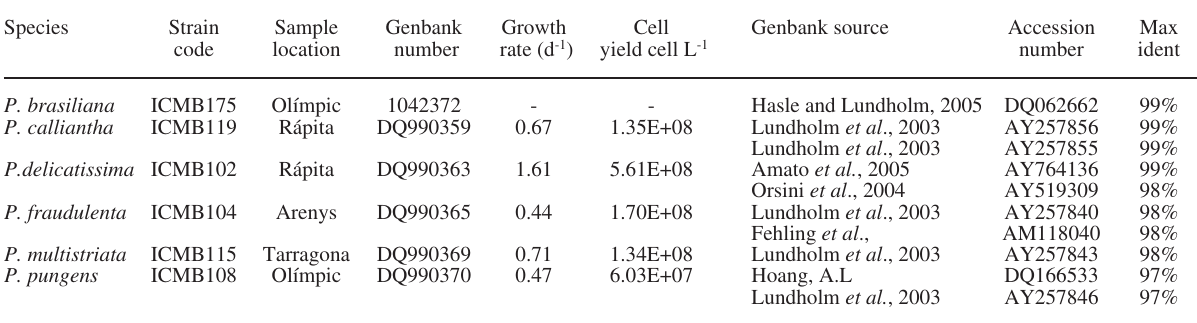
Table 3. – culture strains of different species from nW mediterranean. Strain code, genBank number, growth rate and cell yield of each strain. reference strains were used from the genBank: source, accession number and maximum identity estimated using a Blast analysis. Species Strain Sample genbank growth cell genbank source location number rate (d -1 ) yield cell L -1 ident